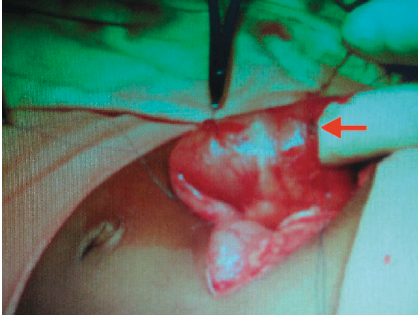
Figure 3: Surgeon passes the finger from the proximal duodenum. Vertical incision along the duodenum shows the web (red arrow).